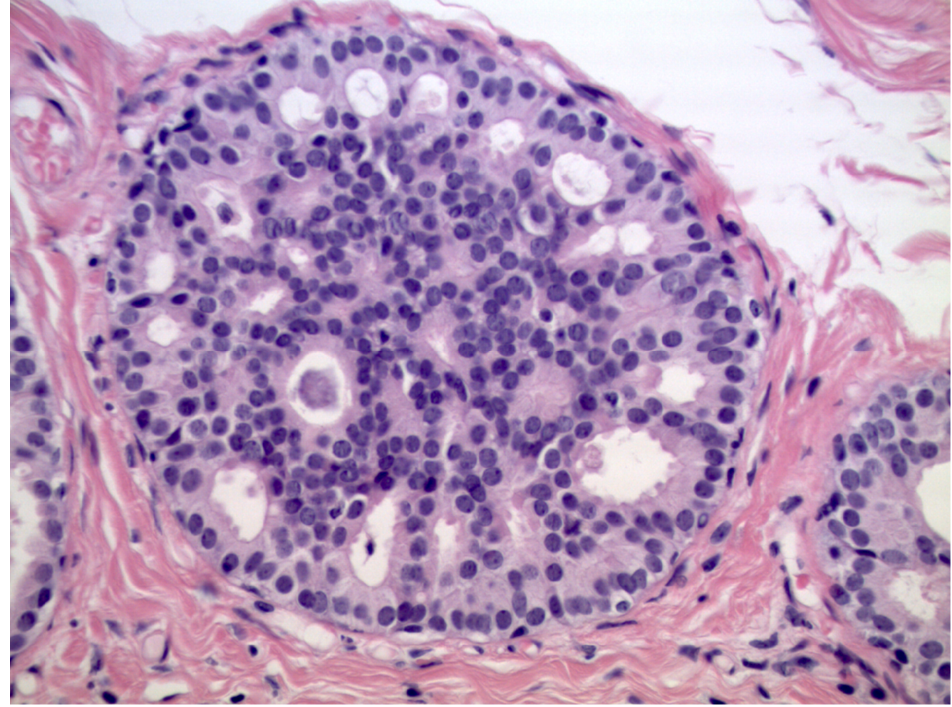
Figure 2. Cribriform ductal carcinoma in situ of low nuclear grade (Hematoxylin &Eosin, 400×).